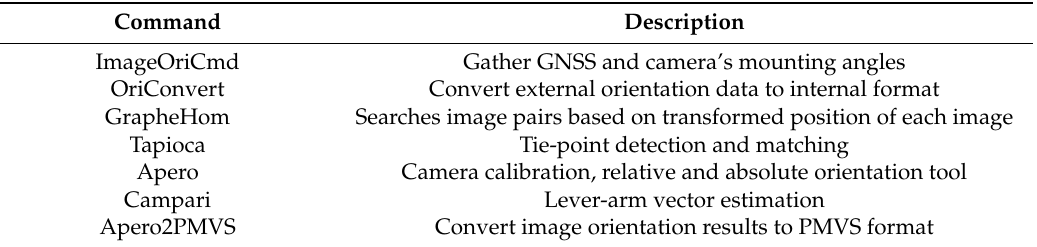
Table 4. Commands for tie-point extraction and image orientation based on